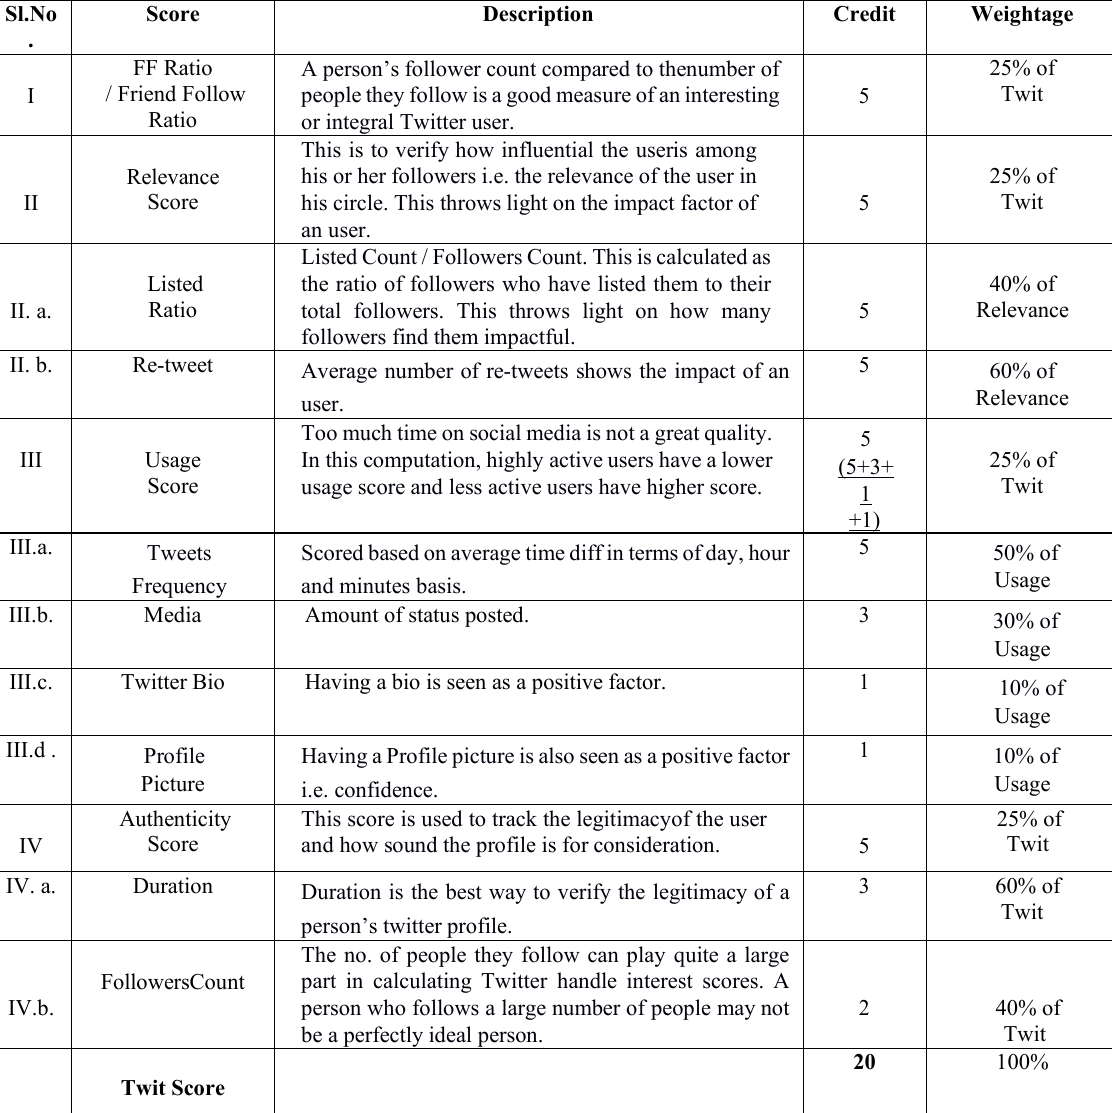
Table 2. Twit Score